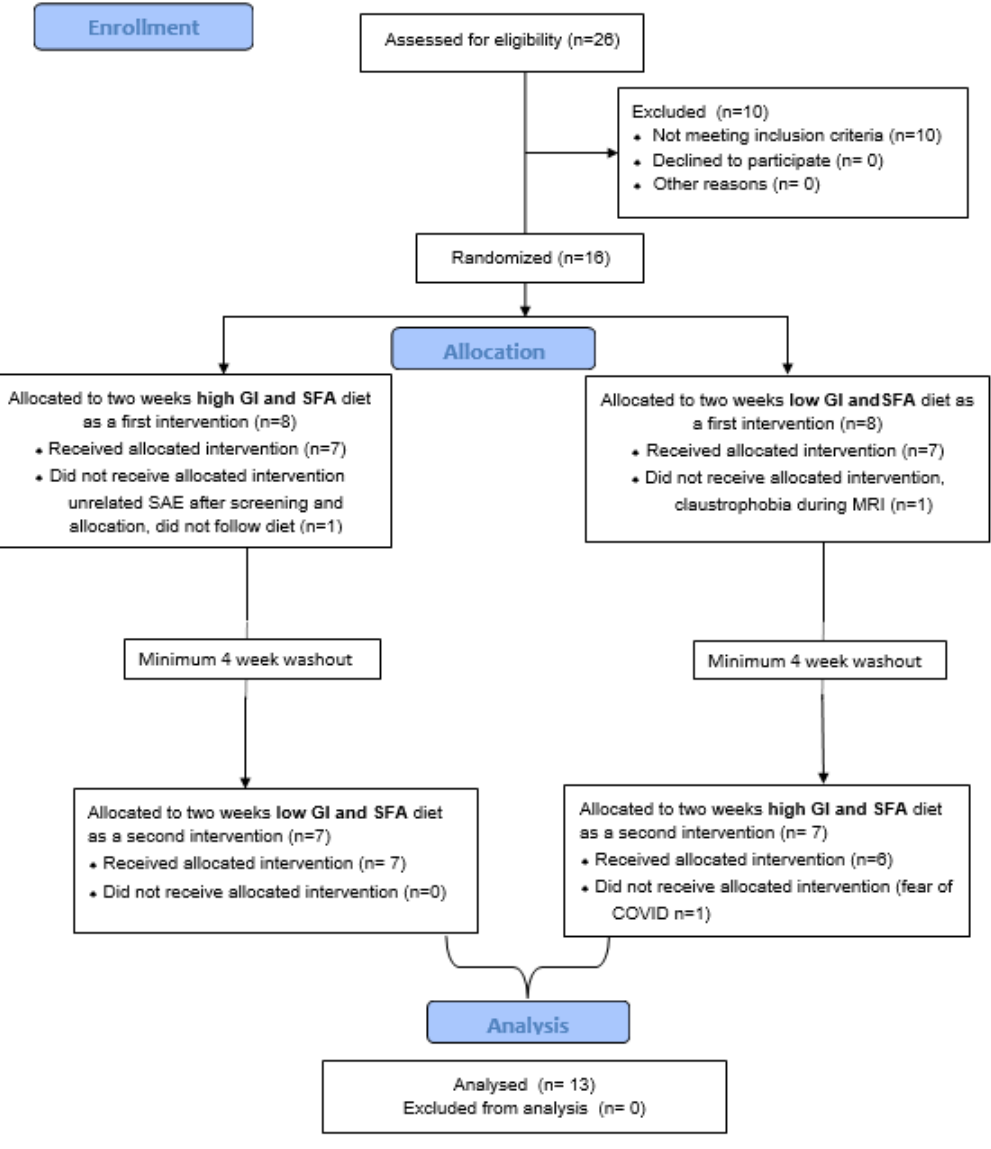
Figure A1. Participant recruitment flowchart. Table A1. Example diets.